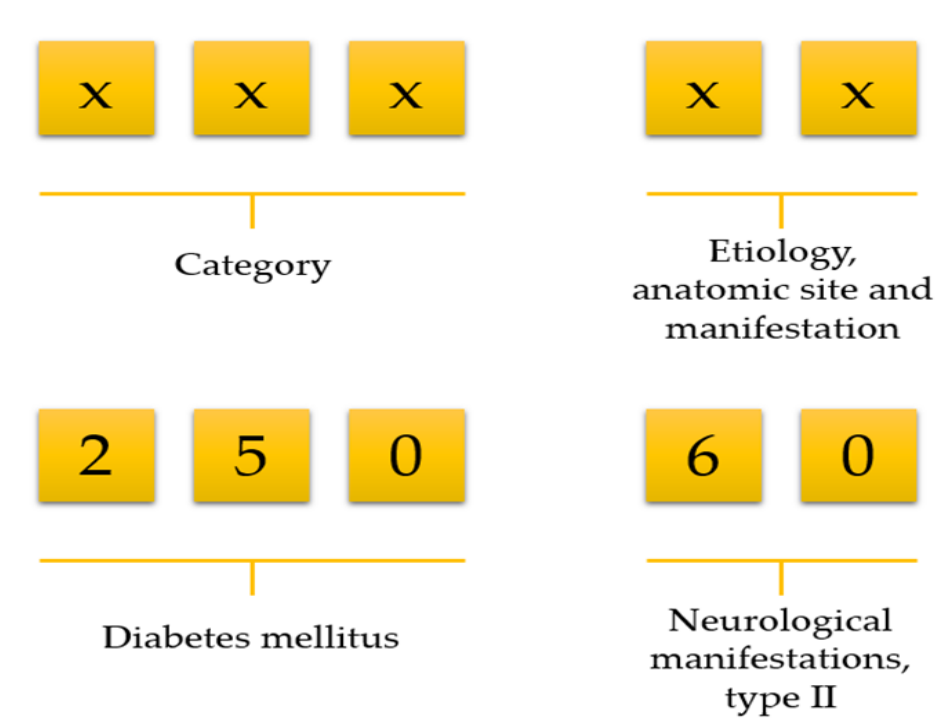
Figure 1. Selection of disease using the first three-digit code.